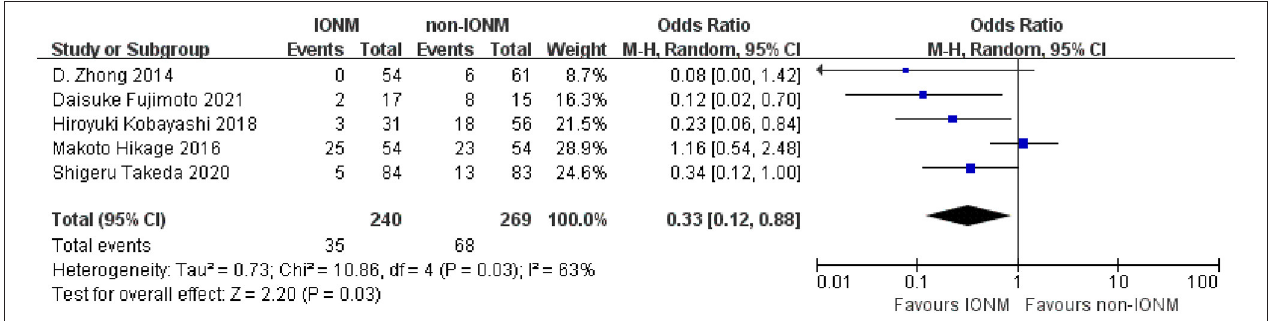
FIGURE 2 | Forest plot showing RLNP rates after thoracoscopic esophagectomy in the IONM and non-IONM